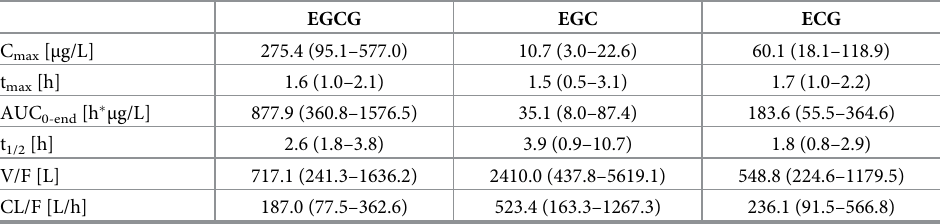
Table 2. Pharmacokinetic parameters and their variability in the study population (5th - 95th percentile), non- compartmental analysis.